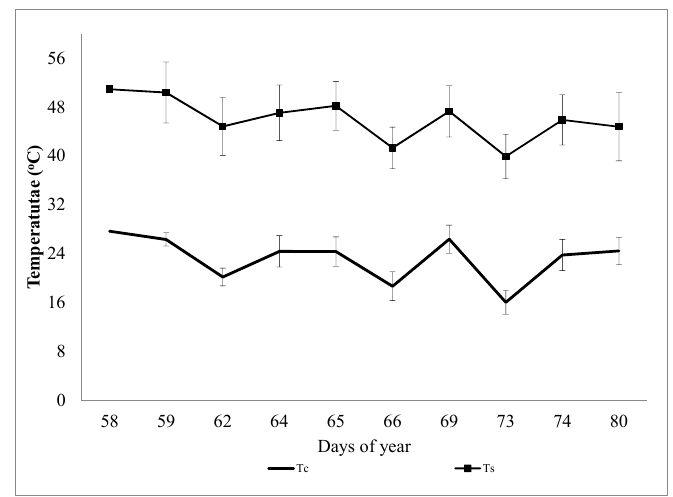
Figure 5. Mean values of surface temperature over a drip-irrigated olive orchard using a thermal camera placed aboard an unmanned aerial vehicle (UAV). Sub-indexes “c” and “s” denote values from the canopy and soil surface, respectively. Vertical lines indicate one standard deviation.